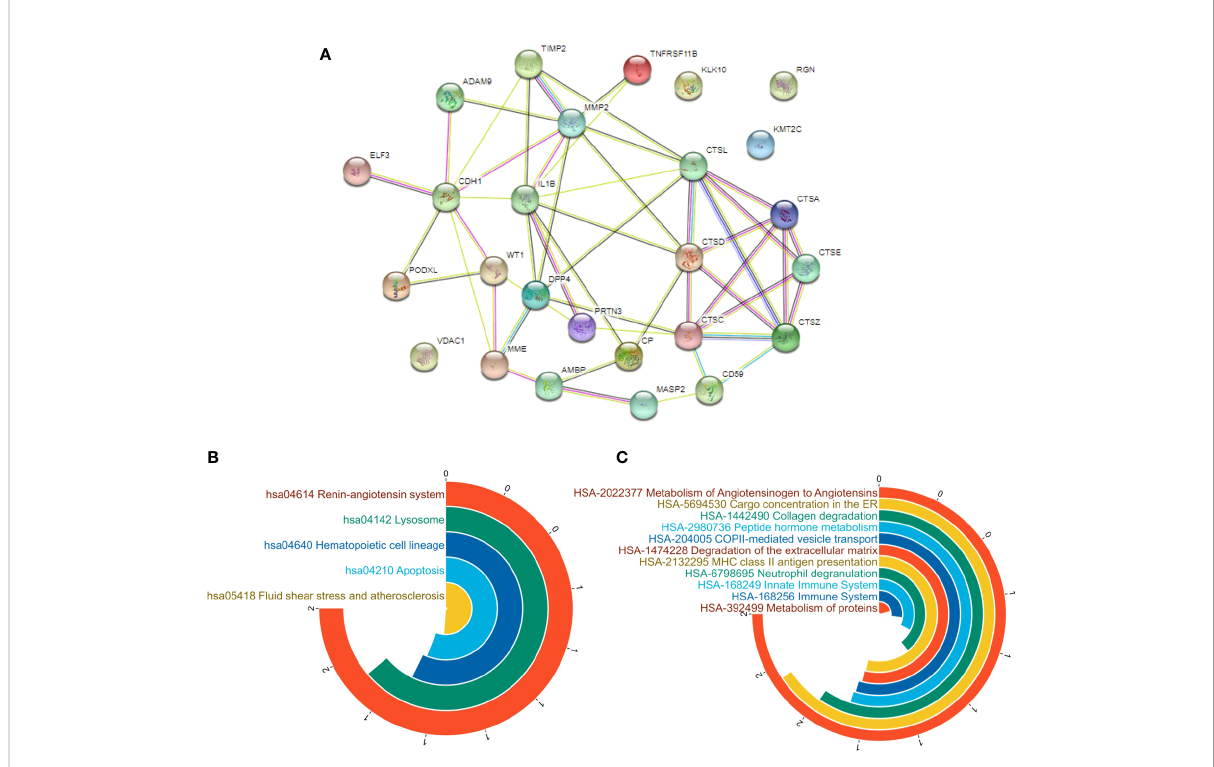
FIGURE 6 PPI analysis of potential biomarkers. (A) the PPI analysis of potential biomarkers; (B) KEGG pathways; (C) reactcome